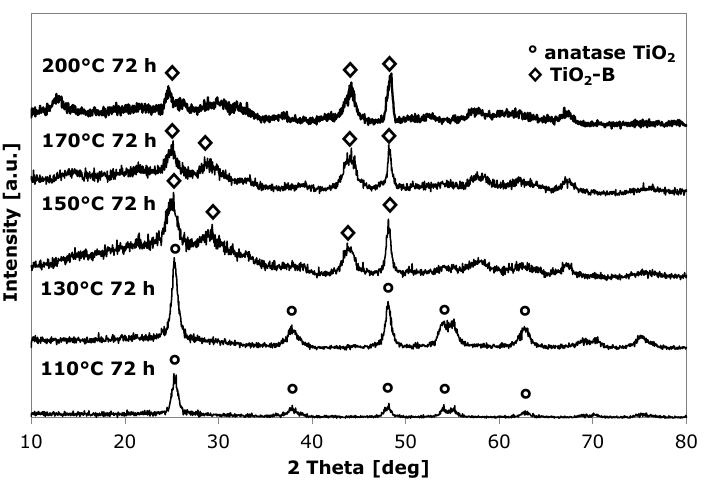
nanowire preparation. 2